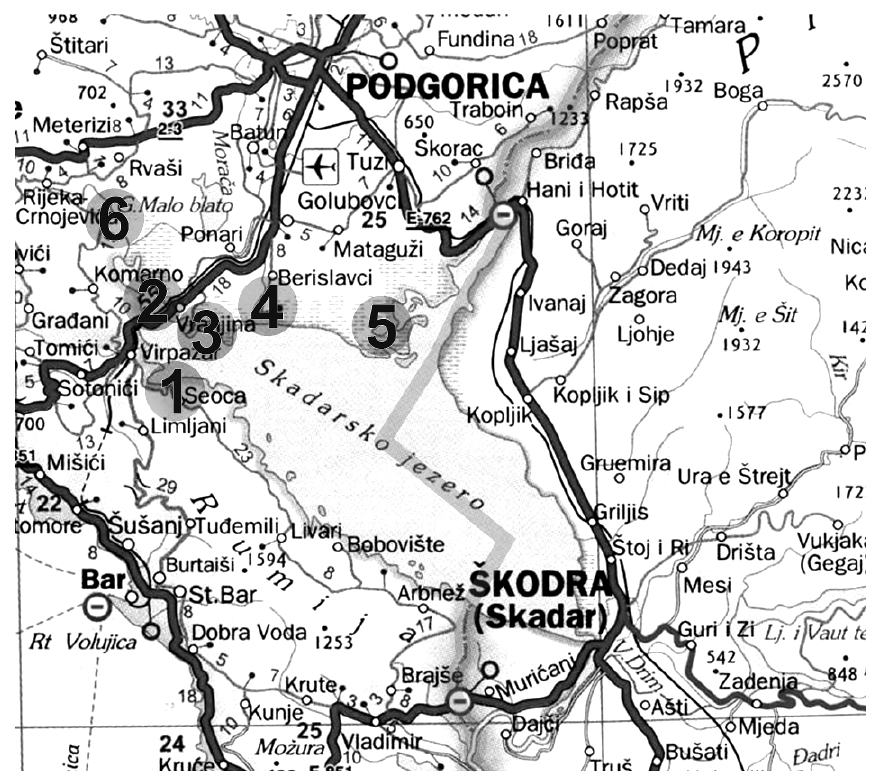
Figure 1. Location of the sampling stations around Lake